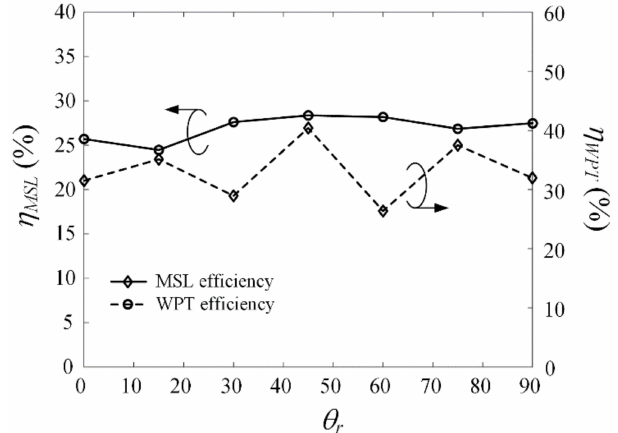
Figure 12. Simulated transmission efficiency and wireless power transfer efficiency according to the rotation